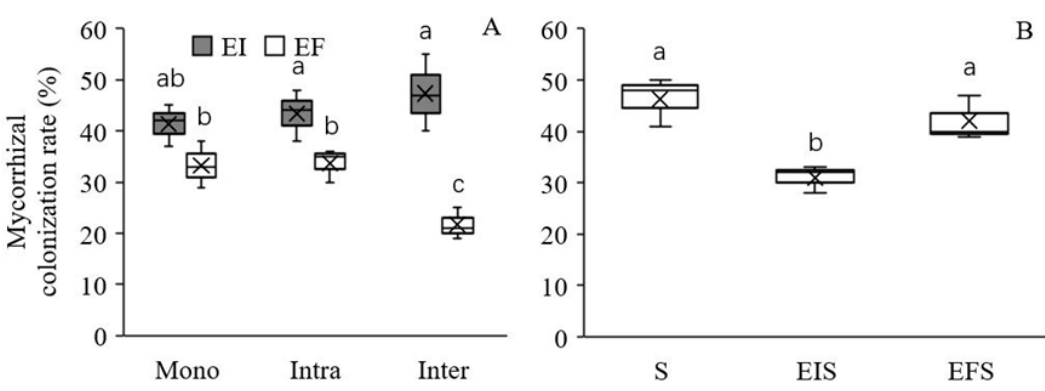
Figure 3. Effect of Epichloë endophyte colonization on the mycorrhizal colonization rate of Leymus chinensis ( A ) and Stipa krylovii ( B ). The different letters above bars denote means that are significantly different among treatments ( p < 0.05). Mono, monoculture; Intra, intraspecific competition; Inter, interspecific competition; S, the monoculture of S. krylovii ; EIS, S. krylovii grown with EI L. chinensis ; EFS, S. krylovii grown with EF L. chinensis . Symbol ‘×’, horizontal line in the box, top and bottom of box edges and bars indicate the average value, median, 25% and 75% quartiles, and 5% and 95% quantiles, respectively.